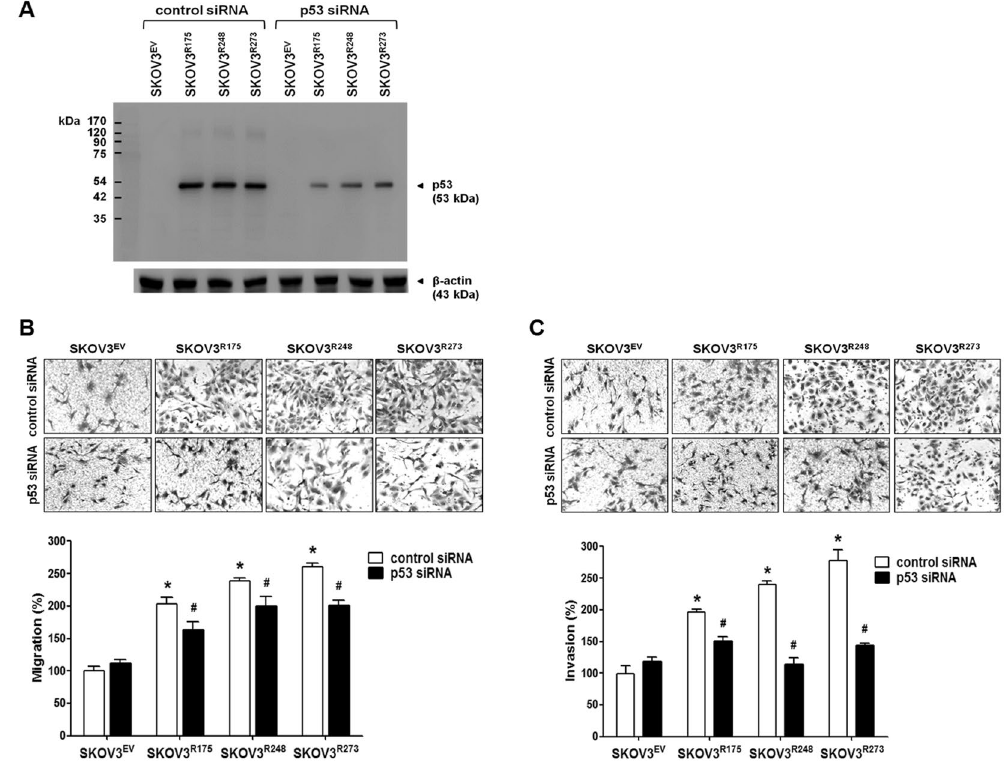
Figure 2. The effect of mutant p53 knockdown on mutant p53-induced ovarian cancer cell migration and invasion. ( A ) Stably transfected SKOV3 EV , SKOV3 R175 , SKOV3 R248 , and SKOV3 R273 cells were transfected with control or p53 siRNA, and then p53 protein levels were measured by western blot assay. β -Actin was used as an internal control. ( B ) After transfection with the siRNAs, the cells were seeded in uncoated chambers for the migration assay and incubated for 24 h. ( C ) After transfection with the siRNAs, the cells were seeded in Matrigel-coated chambers for the invasion assay and incubated for 48 h. Representative images show the migrating ( B ) or invading ( C ) cells. Results are the combined data (mean ± S.D.) from three independent experiments. * P < 0.05 compared with the control siRNA-transfected SKOV3 EV group and # P < 0.05 compared with control siRNA-transfected SKOV3 R175 , SKOV3 R248 , and SKOV3 R273 group,